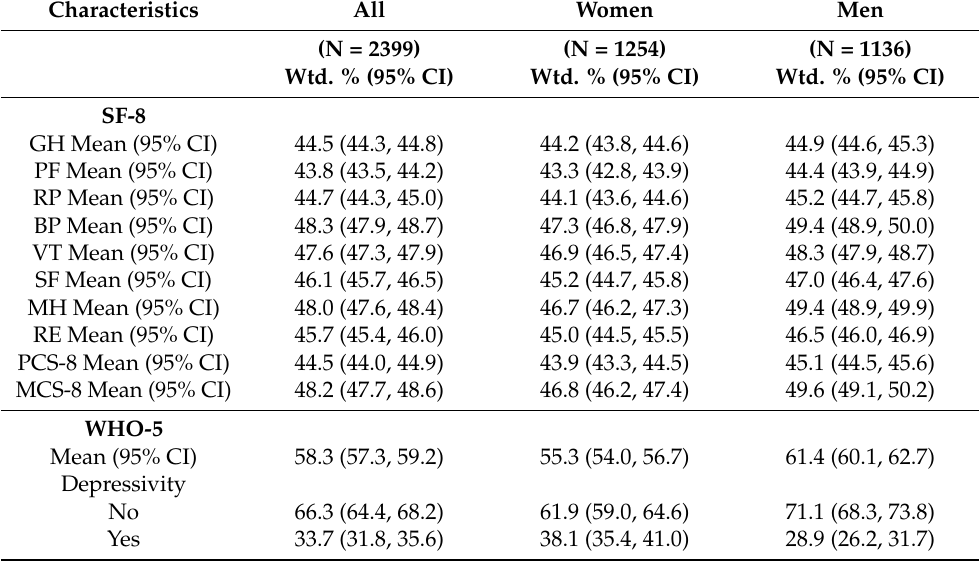
Table 7. Health-related quality of life, well-being, and depressivity of survey respondents, after weighting, by gender.